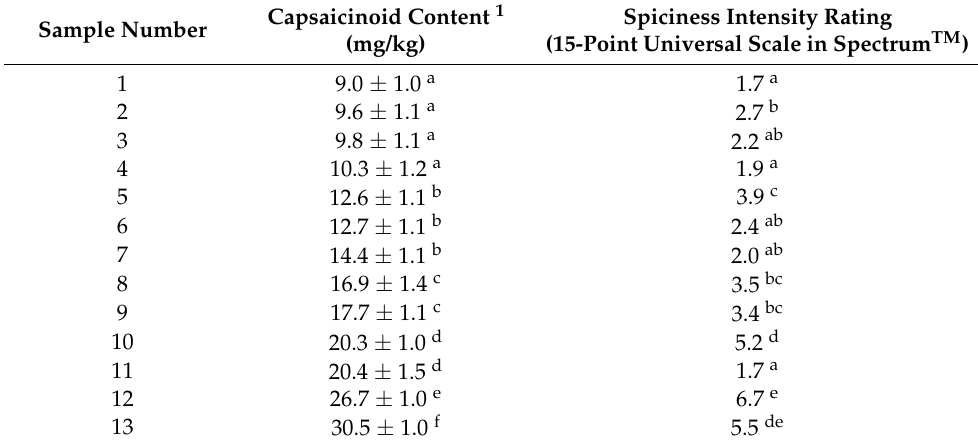
Table 3. Capsaicinoid content of 13 commercial kimchi